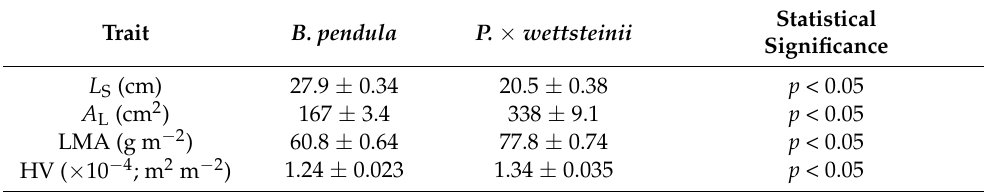
Table 1. Mean values ( ± SE) of shoot morphological traits in silver birch ( Betula pendula ) and hybrid aspen ( Populus × wettsteinii ). L S —shoot length, A L —total leaf blade area of the shoot, LMA—leaf mass per area, HV—Huber